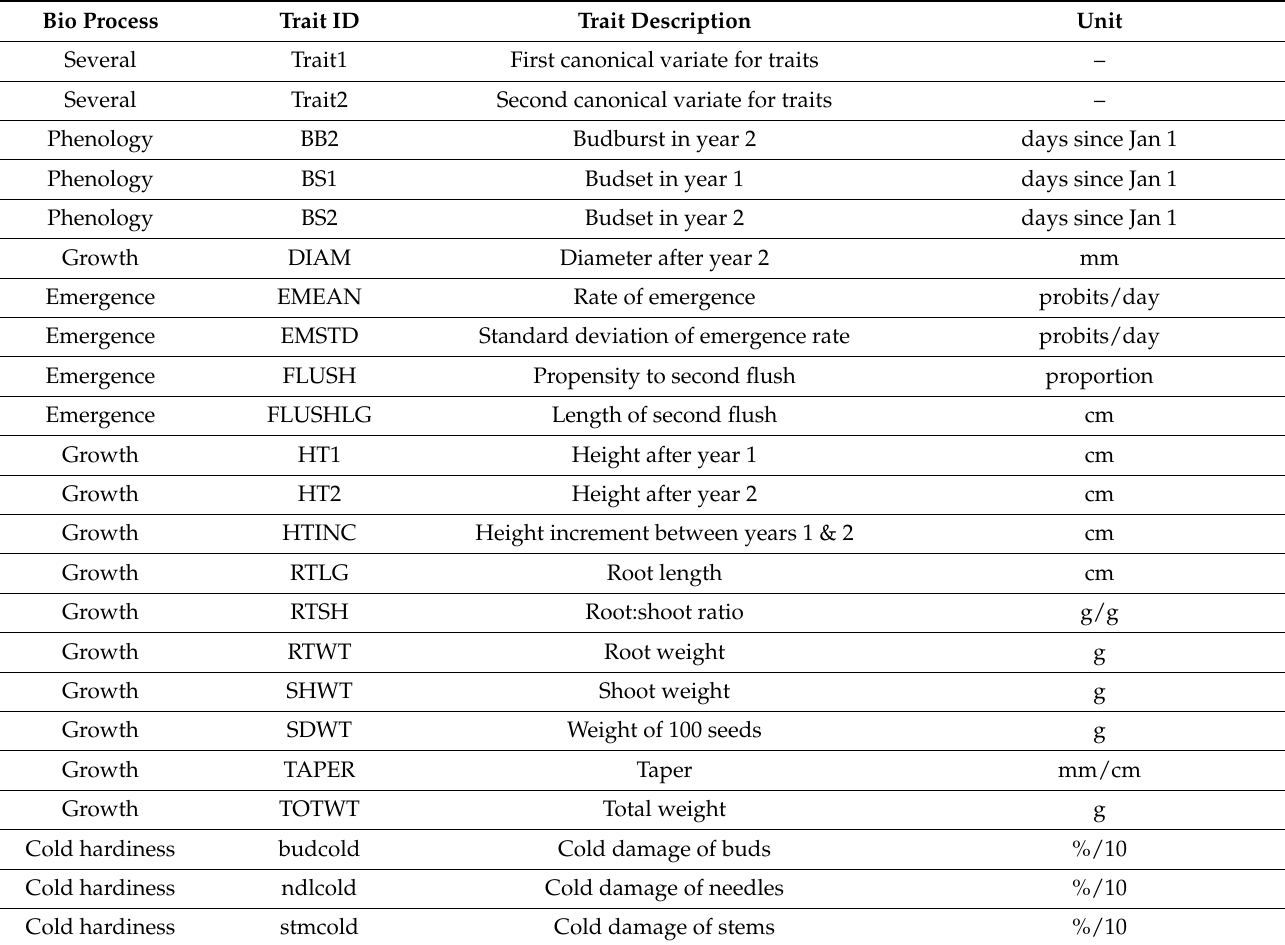
Table A1. Key to phenotypic traits. Variables included are: Biological process (Bio Process), Trait abbreviation (Trait ID), full trait name (Trait description), and units of measurement (Unit).